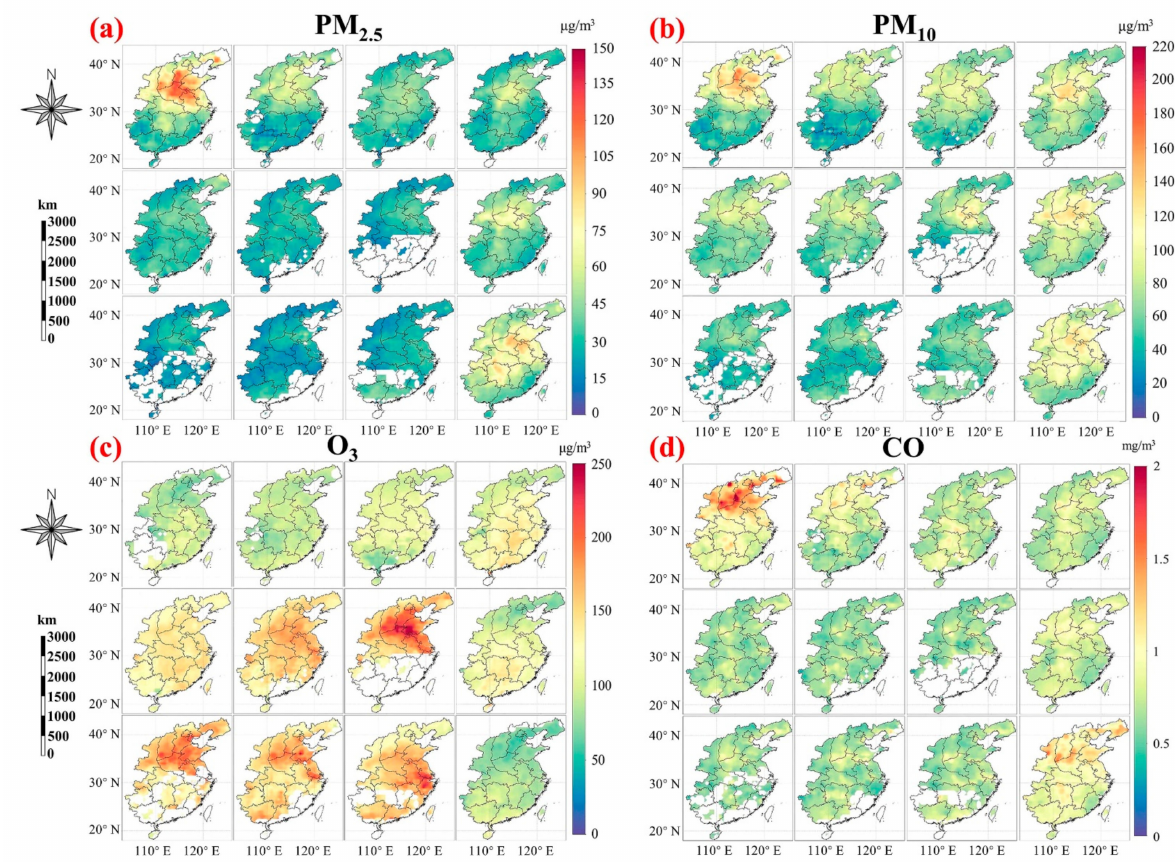
Figure 8. Monthly spatial distributions of model-predicted PM 2.5 , PM 10 , O 3 , and CO concentration in 2020 over the central and eastern China. ( a ) PM 2.5 ; ( b ) PM 10 ; ( c ) O 3 ; ( d ) CO. White area indicates no